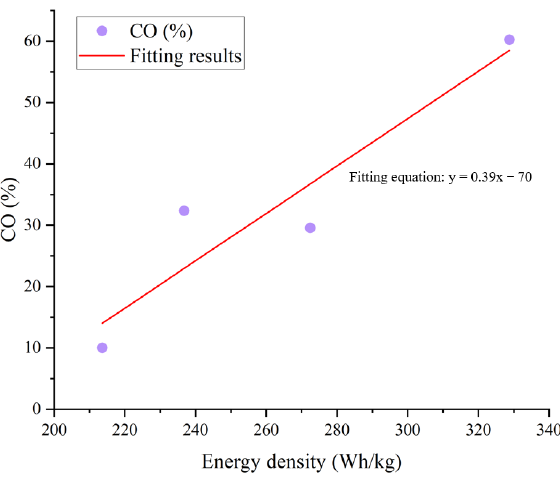
Figure 7. Relationship between CO concentration and battery energy density.